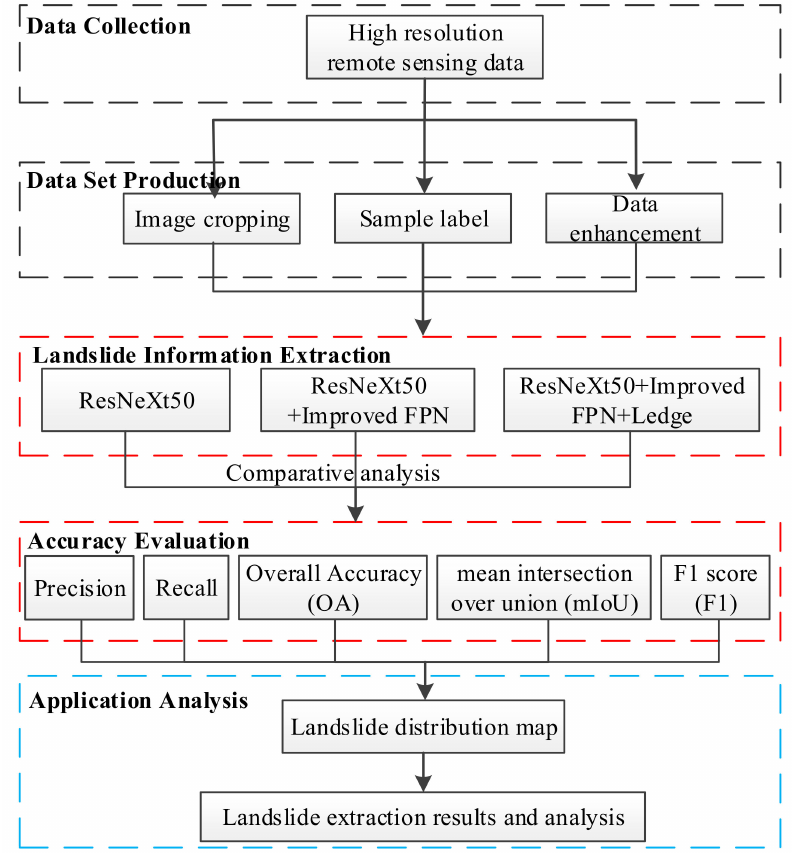
Figure 6. Mask R-CNN